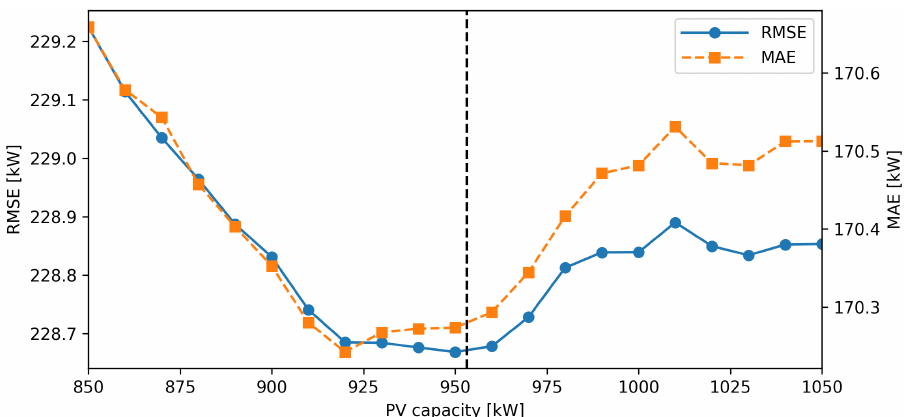
Figure 4. Root mean squared error (RMSE) and mean absolute error (MAE) for load forecast using the approach NL3 as a function of the distributed PV capacity assumed. The vertical line corresponds to the estimated real value obtained by summing up the single utility capacities.